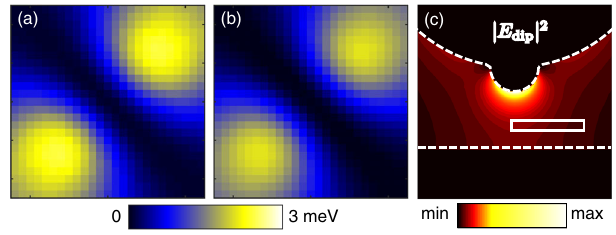
FIG. 12. Interpretation of linewidth maps. (a) Linewidth map calculated using the model described in Appendix A, and (b) linewidth map calculated using the single-mode approxima- 2 ) corresponding to the dipolar tion. (c) Field distribution ( j E dip j plasmon mode resonant with the molecular exciton. The size of the maps is 2 . 5 × 2 . 5 nm 2 , and the size of panel (c) is 4 × 4 nm 2 .